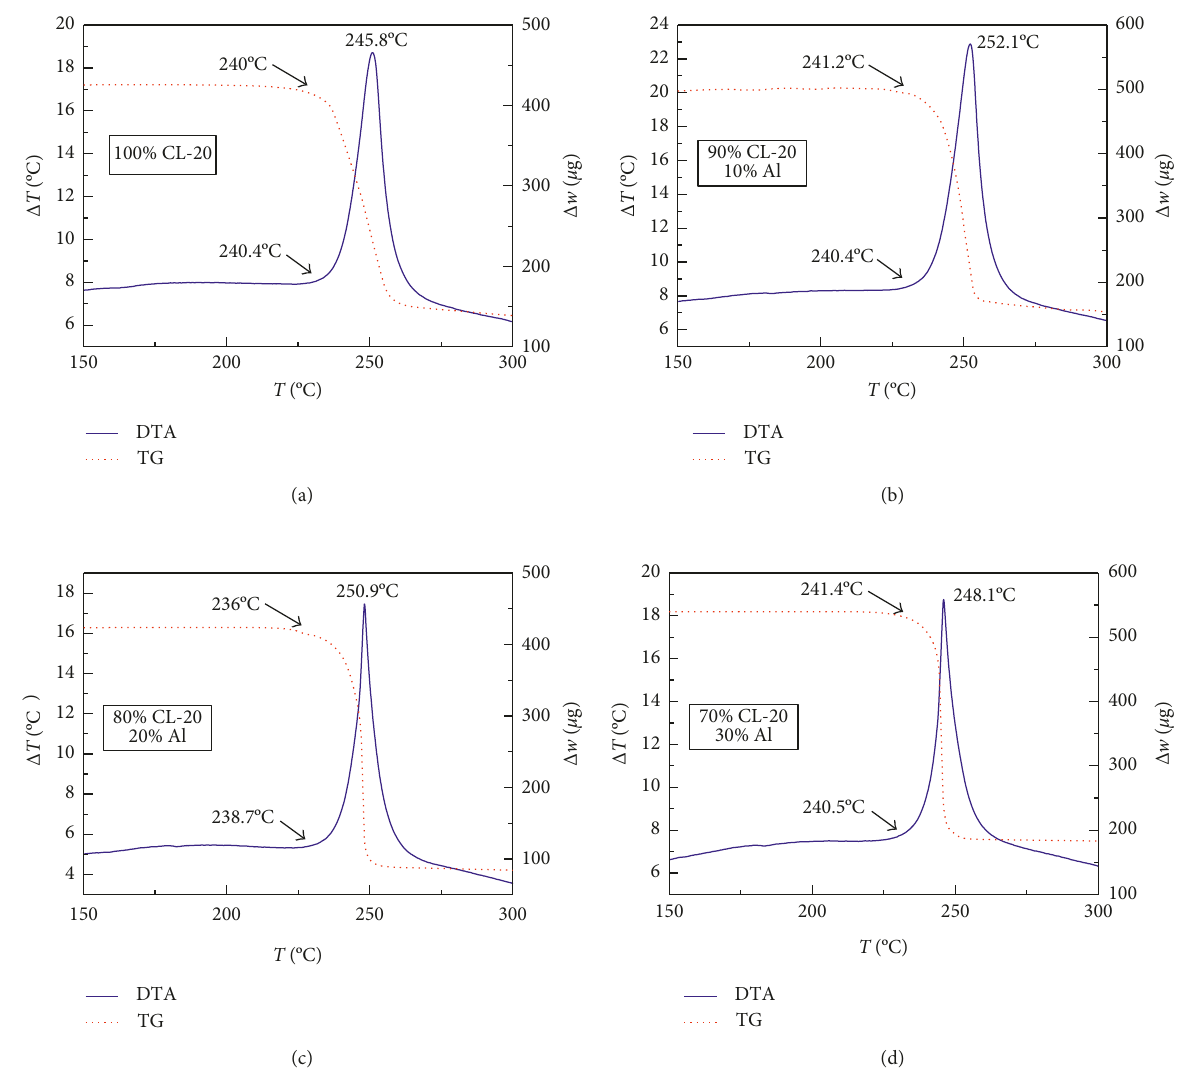
Figure 3: TG-DTA curves of CL-20/Al. (a) Pure CL-20; (b) CL-20 90 wt.% and Al 10 wt.%; (c) CL-20 80 wt.% and Al 20 wt.%; (d) CL-20 70 wt.% and Al 30 wt.%. Table 1: Ignition temperature of the three groups of samples.